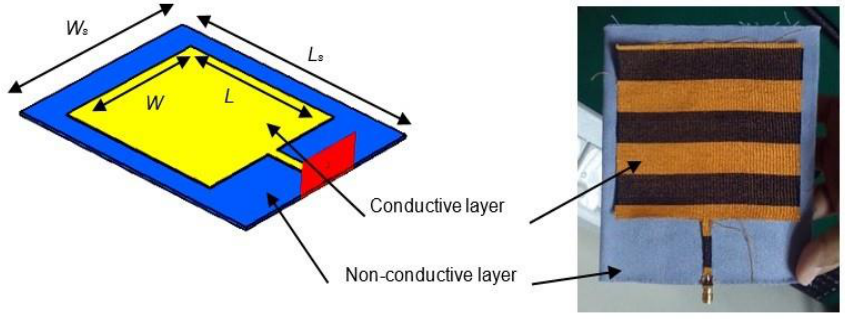
Figure 6. Geometry and structure of 1.575 GHz rectangular electro-textile antenna in the free space condition (Case A), with W/L ratio of 1.1 for the conductive layer and W s /L s ratio of 0.9 for the non- conductive layer. These values have been optimized based on the free space condition.